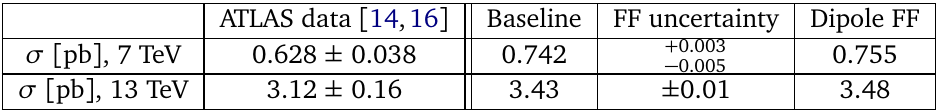
Table 3: Comparison of predictions for exclusive dimuon production in pp collisions, as in Table 2, but showing the uncertainty in the theoretical predictions due to the proton form factors (FFs), evaluated as described in the text. Also shown, for com- parison, is the result using the dipole form factor (5). All results include the survival